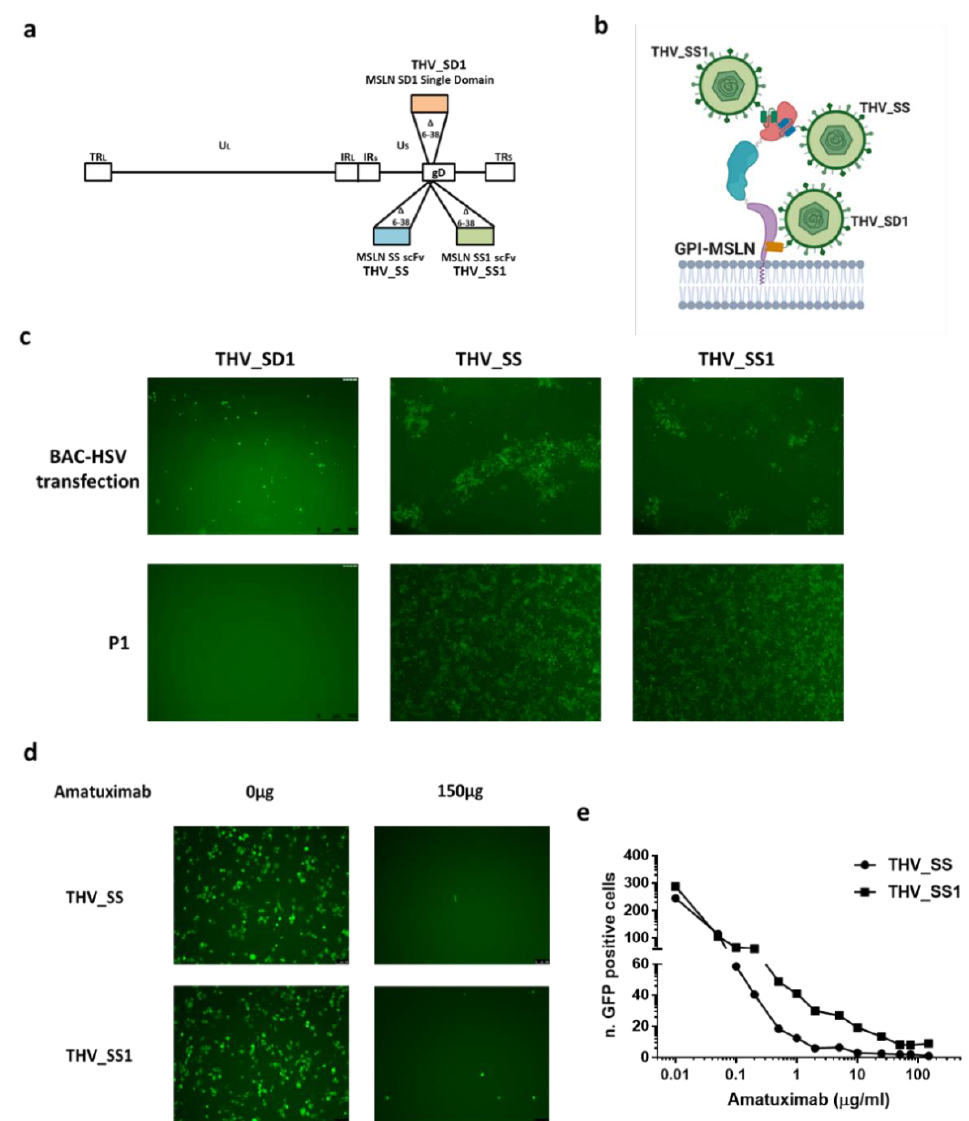
Figure 1. Generation of Herpes simplex type 1 (HSV-1)-based oncolytic viruses retargeted to Mesothelin (MSLN). ( a ) Three targeted Herpes viruses (THVs) were generated by substitution of the essential moiety of viral glycoprotein D (aa 6 to 38) with three different antibody fragments recognizing MSLN: SD1 (orange), SS (light blue), and its affinity matured form SS1 (green) ( b ) targeting two different domains of MSLN. ( c ) THV-SS, THV-SS1, and THV-SD1 Bacterial Artificial Chromosome (BAC) DNAs were transfected in SKOV3 cells to produce infectious viral particles (top panels); THV-SD1 failed to be recovered in first passage of infection (P1) (bottom panel). ( d ) Viral infection and spread were analyzed in presence of the monoclonal antibody Amatuximab (α-MSLN) used at saturating concentration (150 μg) to compete with THV-SS and THV-SS1 viruses. ( e ) The Amatuximab antibody was used at increasing concentrations and the number of eGFP-positive (infected) cells was determined. The statistical significance was calculated by Student’s t -test and resulted p < 0.05 in the range of Amatuximab concentration between 0.1 and 50 μg/mL.